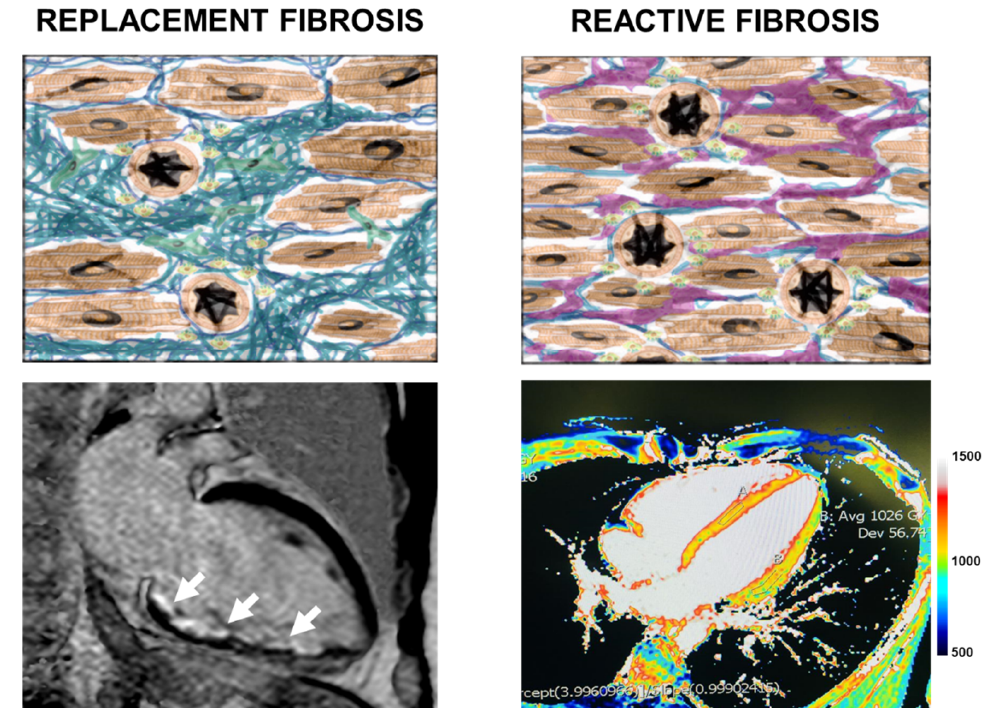
Figure 3. Description of the main patterns of myocardial fibrosis and the corresponding cardiac magnetic resonance images. Right panel: replacement fibrosis occurs in response to cardiomyocyte loss and can be observed in LGE image as a regional subendocardial scar (white arrows). Left panel: reactive fibrosis occurs without cardiomyocyte loss and can be observed in native T1 mapping image as raised native T1 values (1000–1200